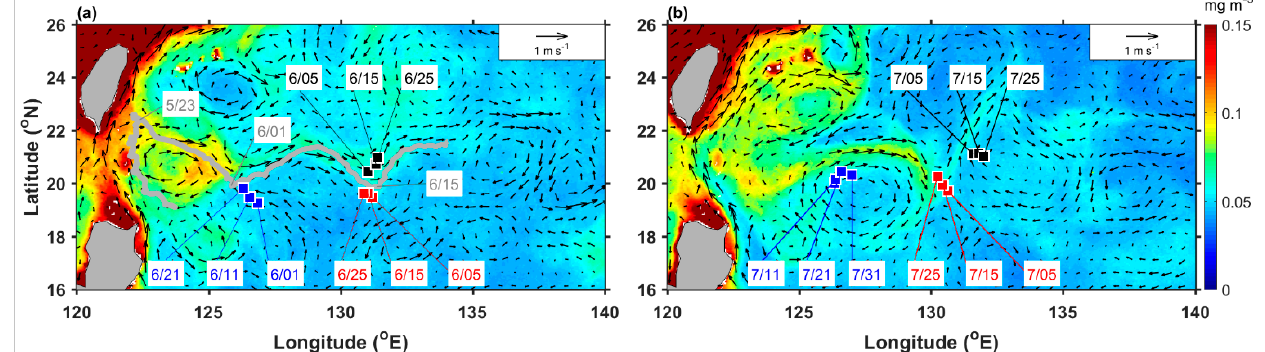
Figure 3. The monthly maps of 1/24 ◦ -gridded chlorophyll-a (Chl-a) concentrations (color shaded) and 1/4 ◦ -gridded absolute geostrophic velocities (arrows) in ( a ) June and ( b ) July 2010. The square symbols in blue, red, and black show the locations of Argo 5901521, 5901512, and 2901588, respectively, from west to east roughly along the high Chl-a filament. The gray curve in ( a ) shows the trajectory of drifter 22527 in May and June. The high Chl-a filament located along 21 ◦ N within 125 ◦ E and 135 ◦ E shows the footprint of the eastward cross-shore Kuroshio branch (ECKB). The dates (month/days) given in same colors point to the corresponding locations of the drifter and Argo floats.